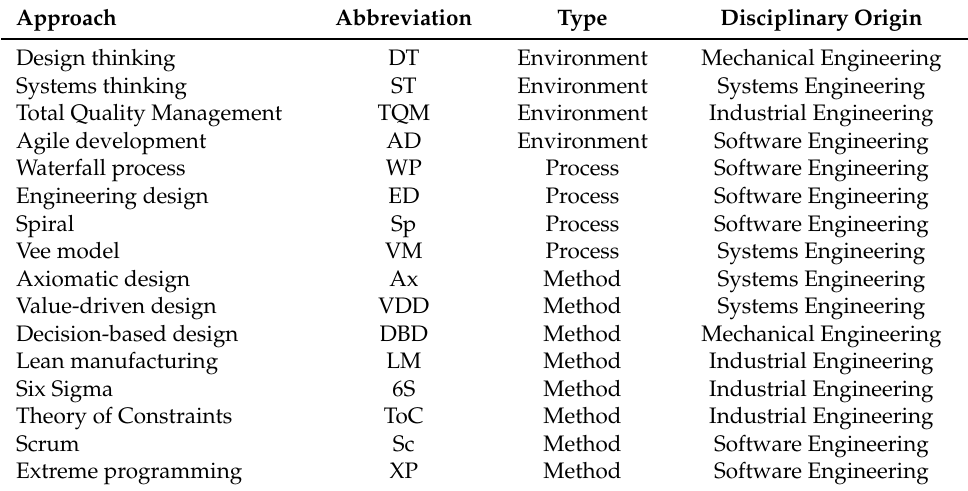
Table 1. Well-established design approaches included in the review and PD